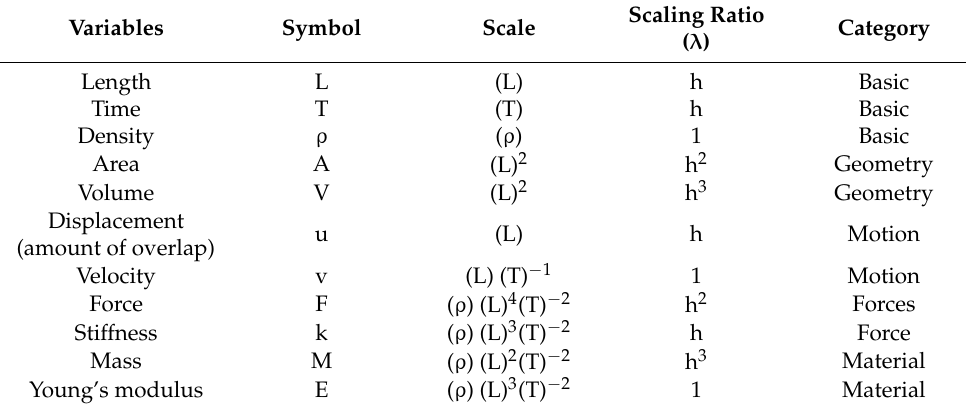
Table 2. Basic physical properties of coated powder. Variables